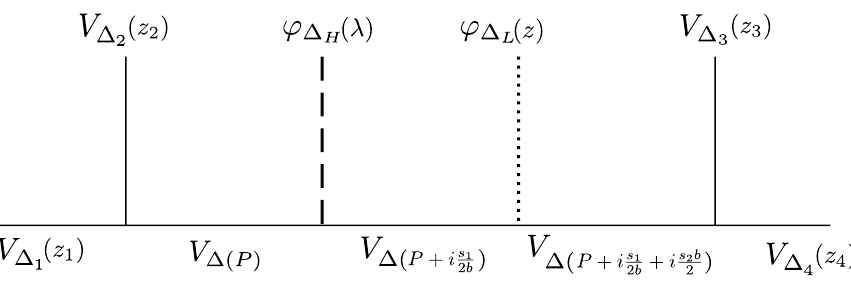
Figure 1 . 6-point conformal block with one heavy and one light insertion. The intermediate momenta are labeled by P and two integers s 1 ; s 2 = (cid:6) 1